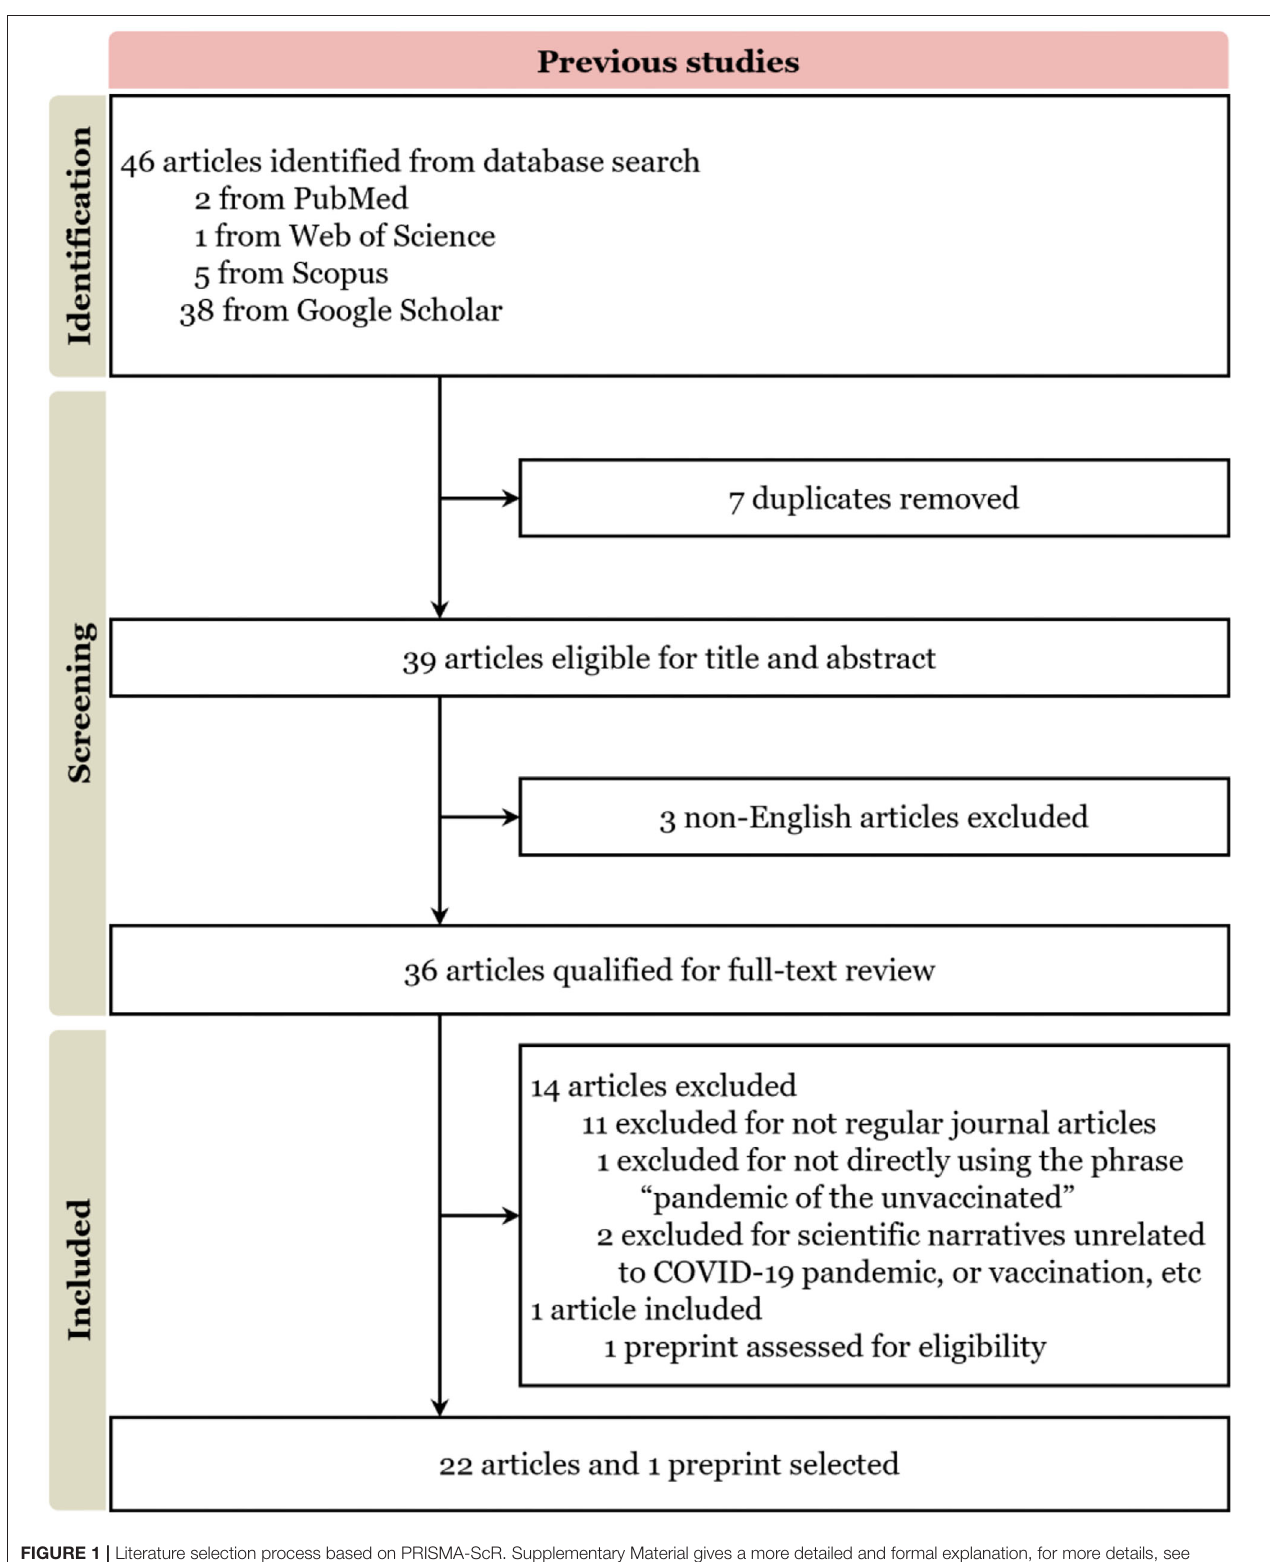
FIGURE 1 | Literature selection process based on PRISMA-ScR. Supplementary Material gives a more detailed and formal explanation, for more details, see Supplementary Table 2 (Final reference list).